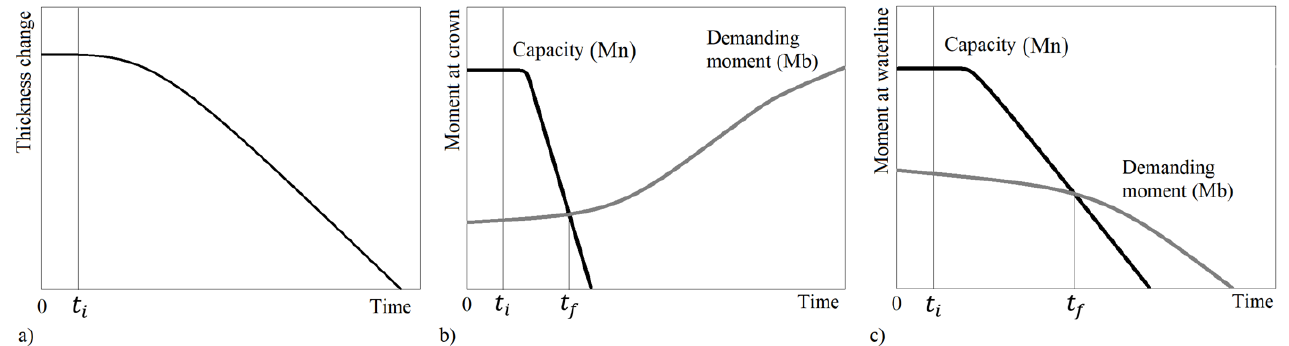
Figure 5. Sequence of changes in the thickness and strength produced by biodeterioration in sewers: ( a ) thickness change, ( b ) first failure mode produced by variations of strength and demand at the crown, ( c ) second failure mode produced by variations of strength and demand at the waterline walls.